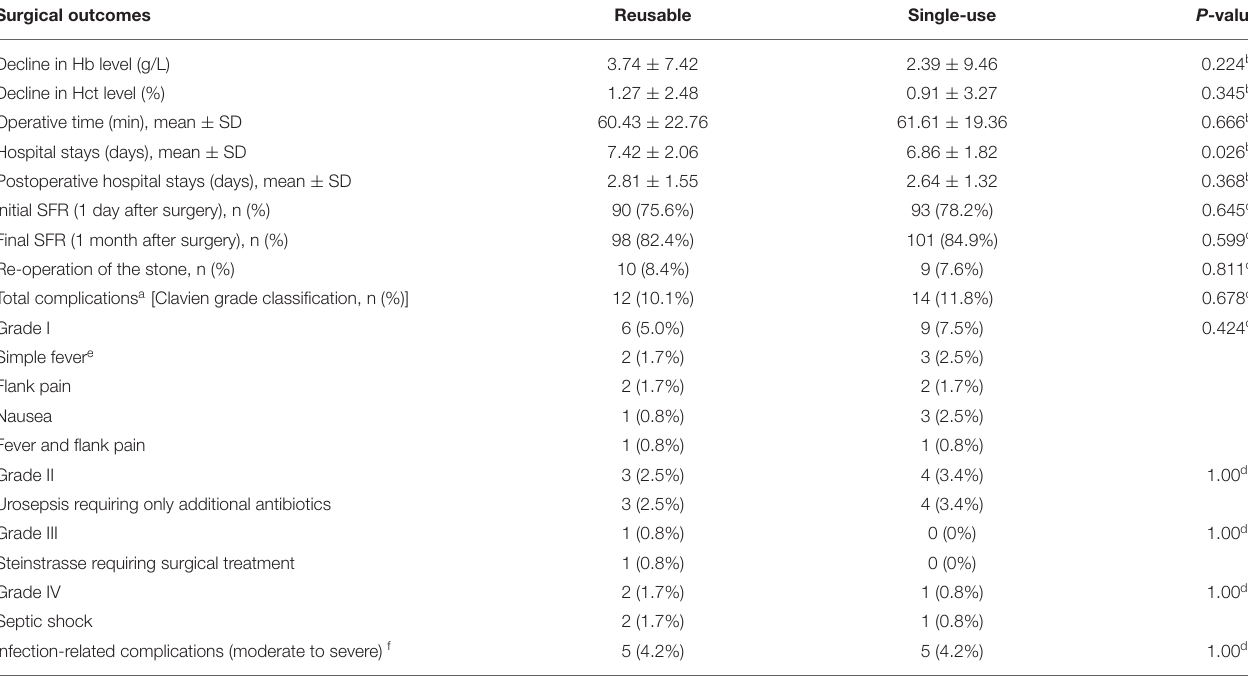
TABLE 2 | Treatment outcomes of the reusable FURS group and the single-use FURS group. Surgical